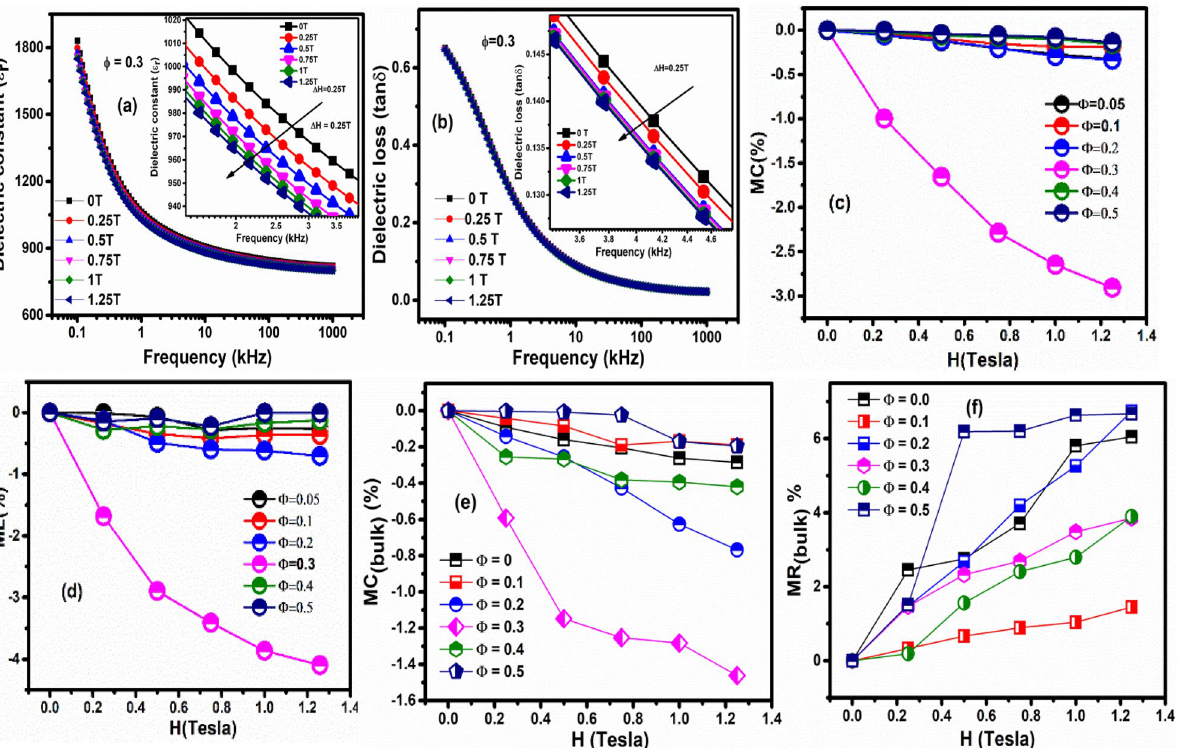
Figure 5. Variation of ( a ) dielectric constant (ε r ) and ( b ) dielectric loss (tanδ) versus frequency for Φ = 0.3 in presence of various magnetic fields respectively. Inset shows the enlarged view of the graph to show the effect of magnetic field to these dielectric parameters. Variation of calculated ( c ) magneto-capacitance (MC%) and ( d ) magneto-loss (ML%) with applied magnetic fields for various compositions. Variation of ( e ) MC (bulk) % and ( f ) MR (bulk) % with magnetic field obtained from the fitting of the Nyquist